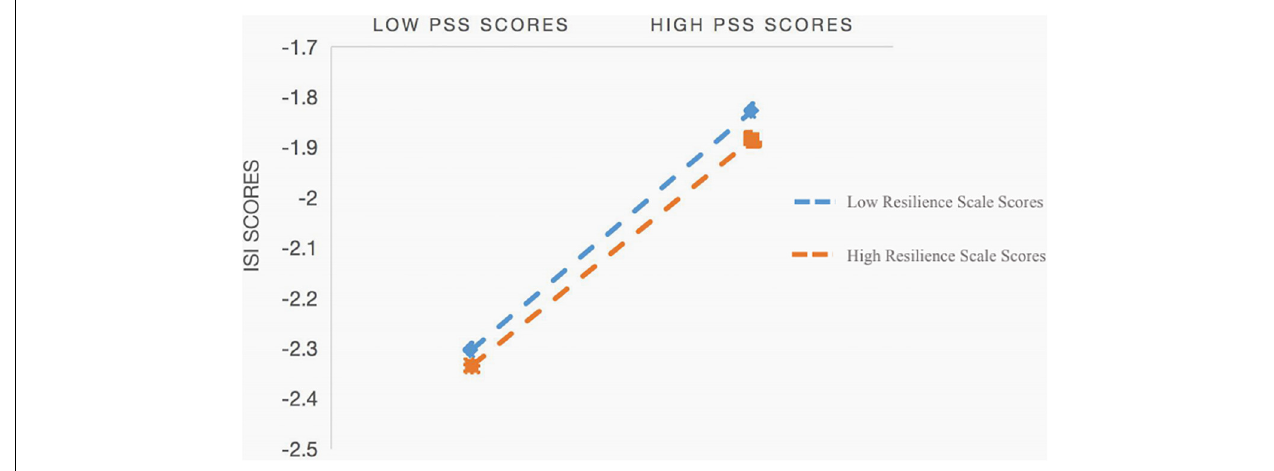
FIGURE 1 | Interaction of Perceived Stress Scores and Resilience Scores on Insomnia Severity Scores. PSS means Perceived Stress Scale, ISI means Insomnia Severity